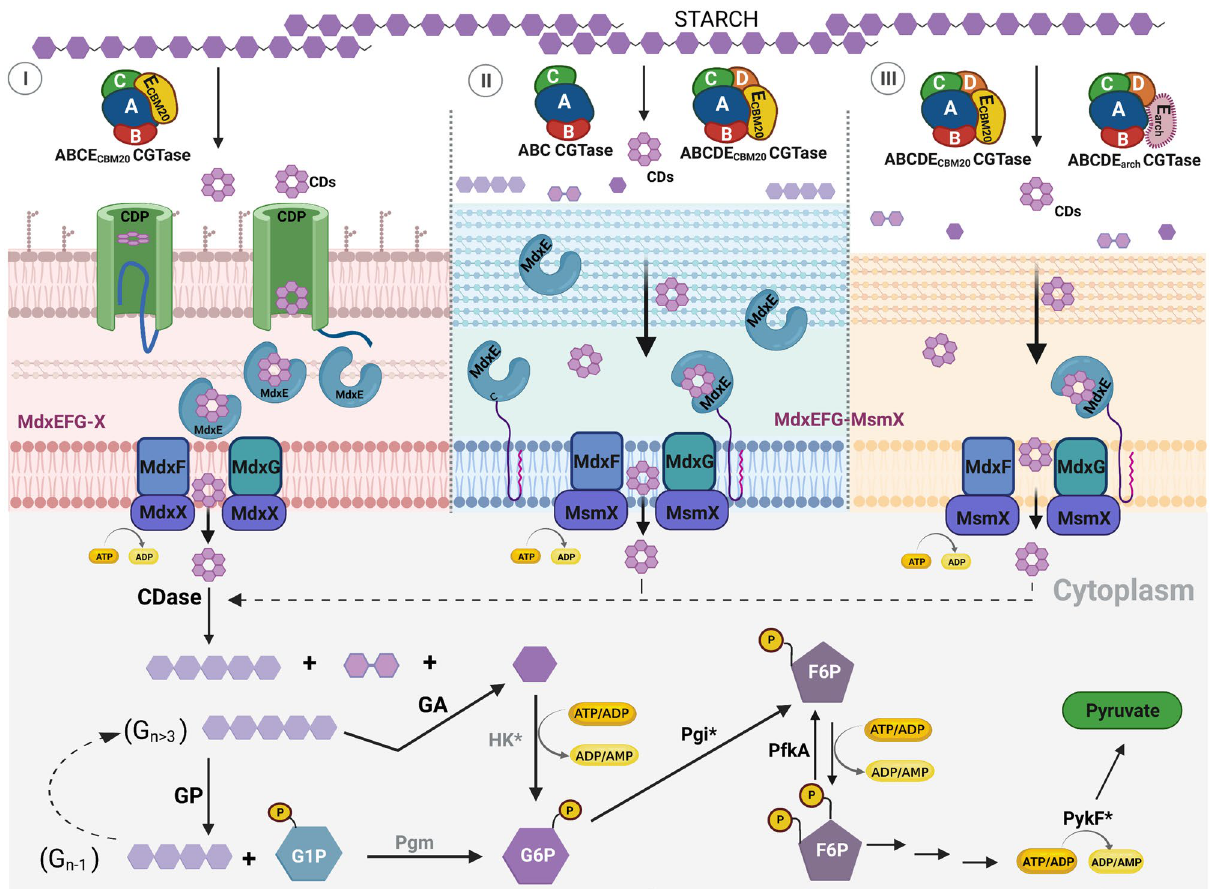
Figure 5. Proposed CM-CD pathway in G− bacteria (I), G+ bacteria (II), and archaea (III). Note the proteins involved in the four steps of the CM-CD pathway. (i) Synthesis: four-domain CGTases in G−, three- and conventional five-domain CGTases in G+ , and five-domain CGTases in archaea with either E CBM20 /E arch domains at the C-terminal region. (ii) Translocation/Internalization: MdxEFG-(X/MsmX) transporter